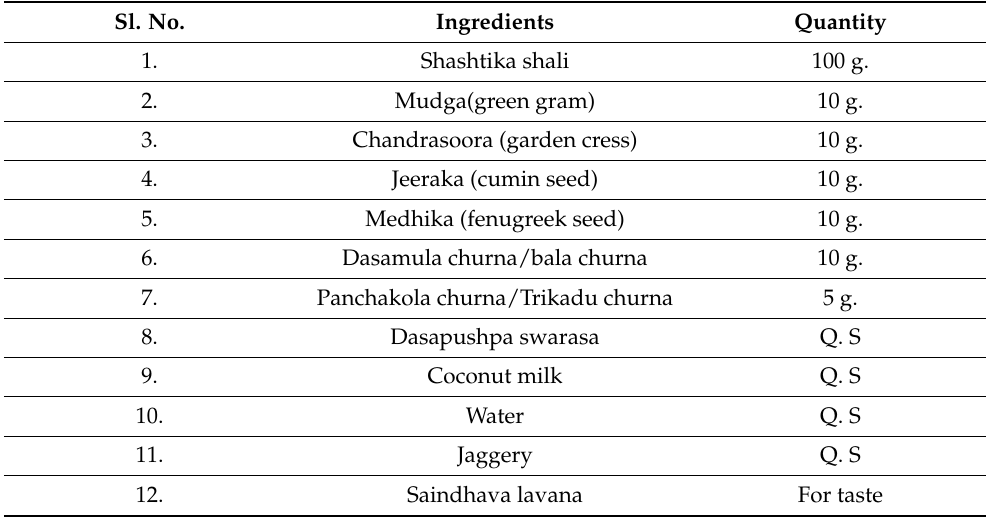
Table 1. Karkkidaka kanji